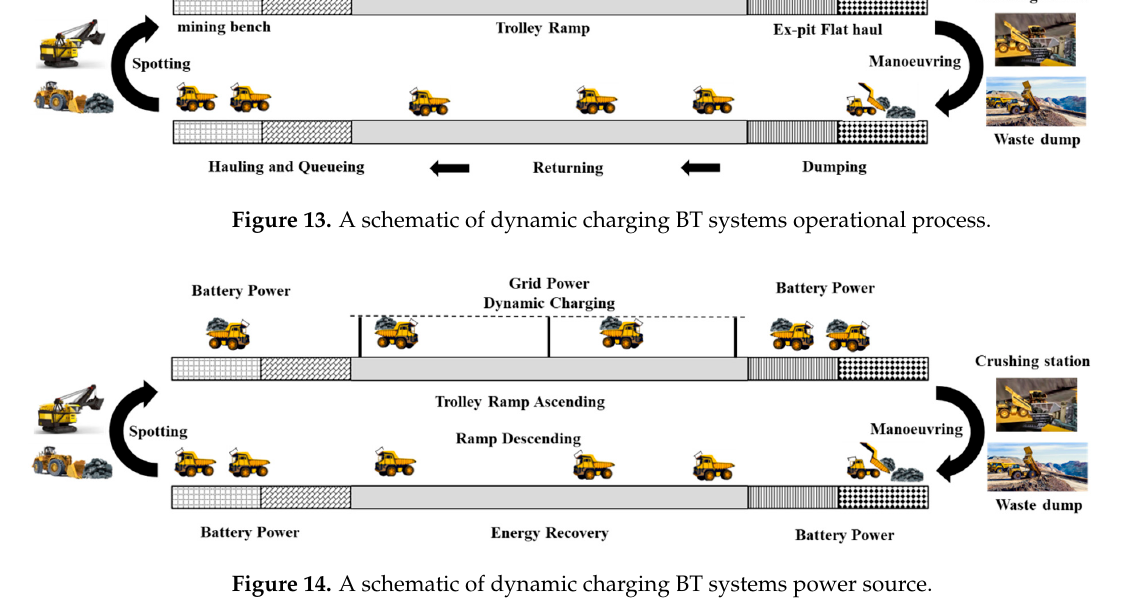
Figure 16. A schematic of a typical BT systems power source. 3.